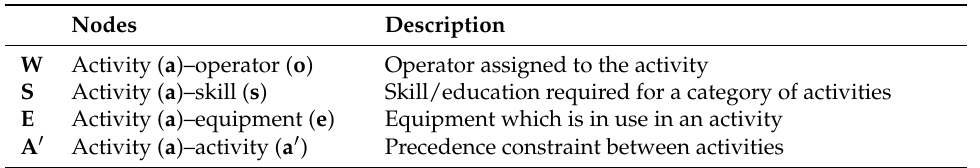
Table 1. Definition of the biadjacency matrices of the bipartite networks used to illustrate how a multidimensional network can represent a production line.